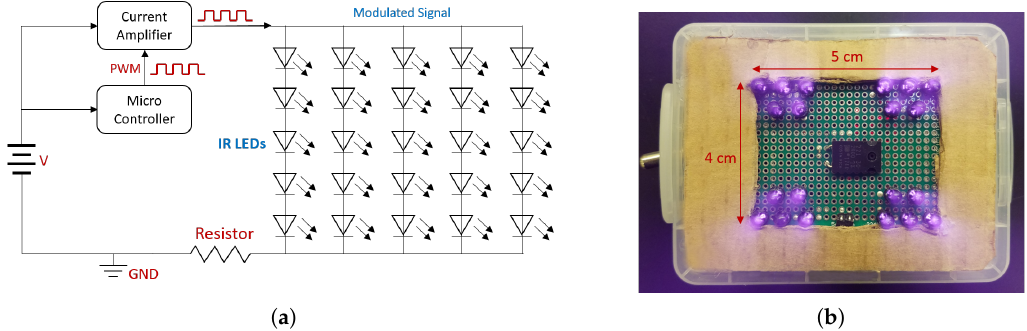
Figure 3. Protoype IR Beacon—total four IR blobs each of which consists of five IR LEDs. ( a ) IR Beacon Electric Circuit Diagram; ( b ) Prototype of the IR Beacon.